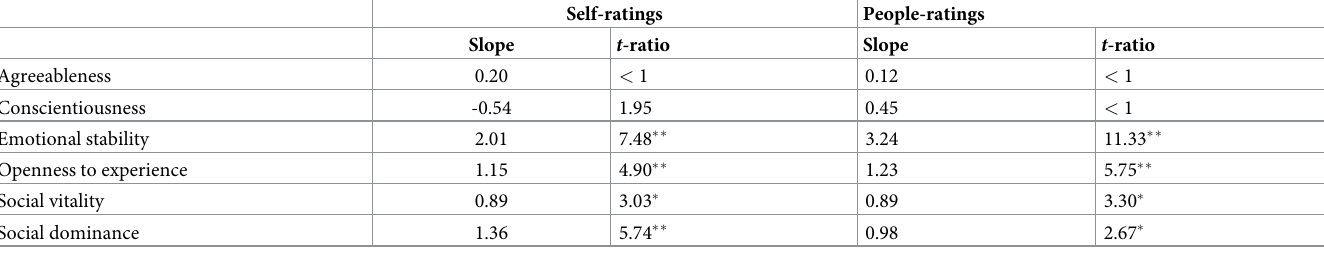
Table 4. Correspondence between perceived changes in personality traits over the lifespan and changes estimated by meta-analysis.